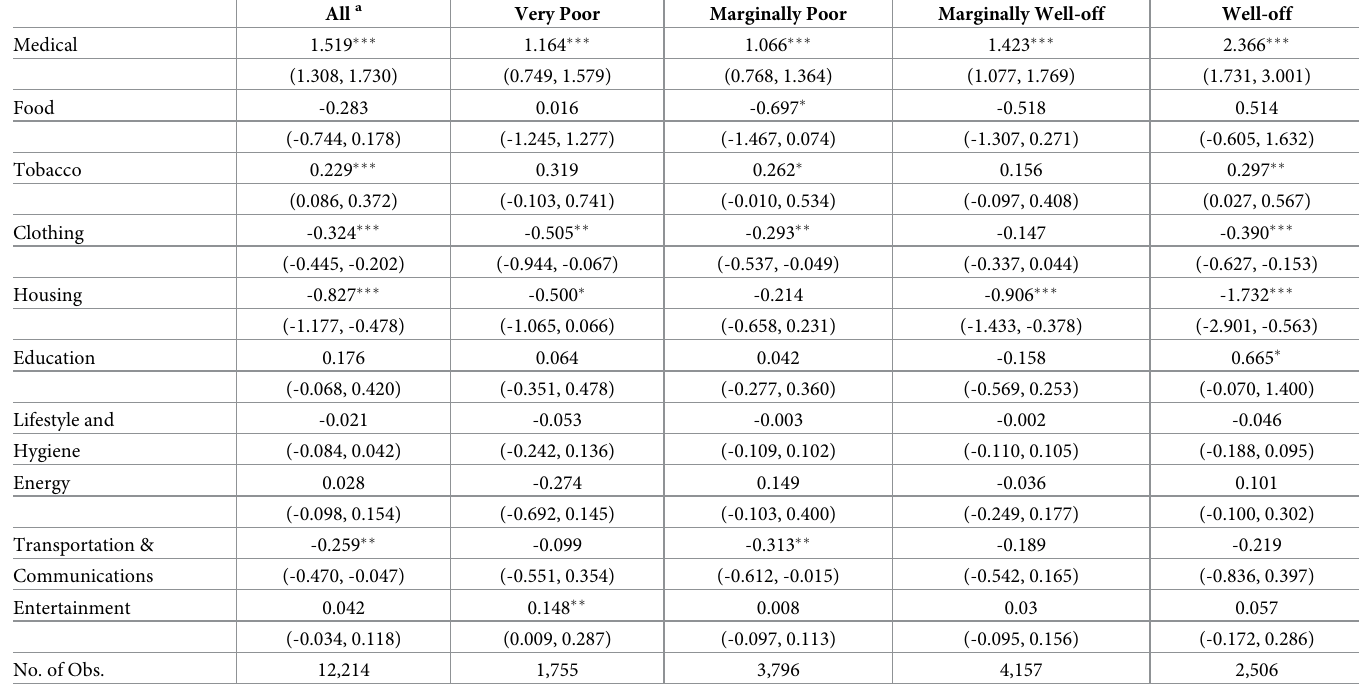
Table 4. Adjusted differences in expenditure categories between NCD and non-NCD